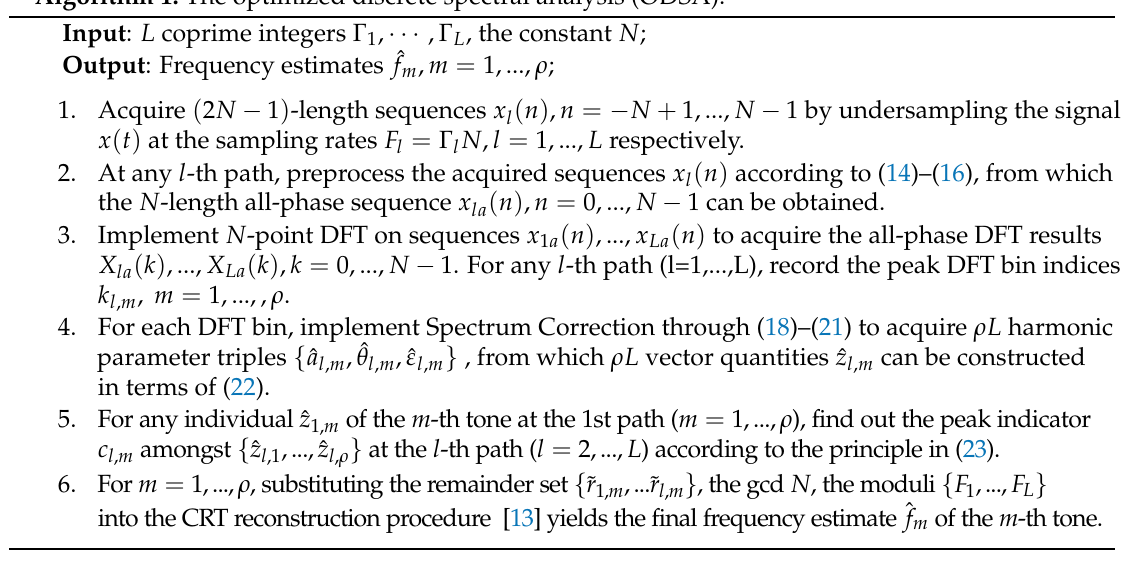
Algorithm 1: The optimized discrete spectral analysis